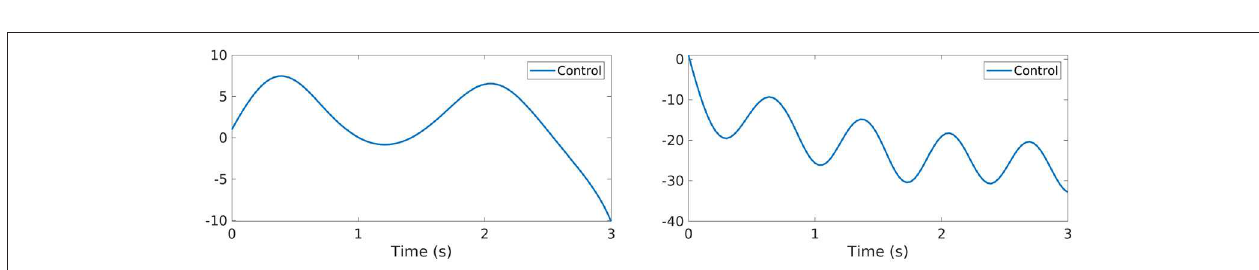
u for the Kuramoto model [Equation (23)] with N b